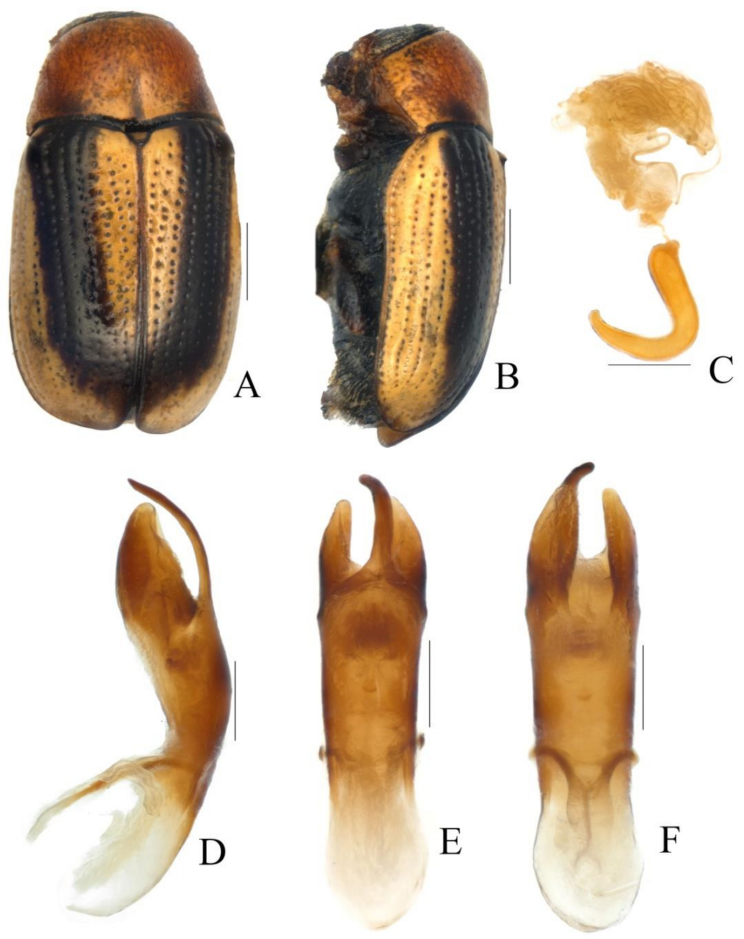
Figure 17. Cryptocephalus ( Burlinius ) flavolimbatus Pic, 1920: ( A ) habitus; ( B ) lateral view of habi- tus; ( C ) spermatheca; ( D ) lateral view of aedeagus; ( E ) dorsal view of aedeagus; ( F ) ventral view of aedeagus. (Scale bars: ( A , B ) = 0.5 mm, ( C – F ) = 0.2 mm) (( A , B , D – F ): male; ( C ): female; both from Yunnan.)